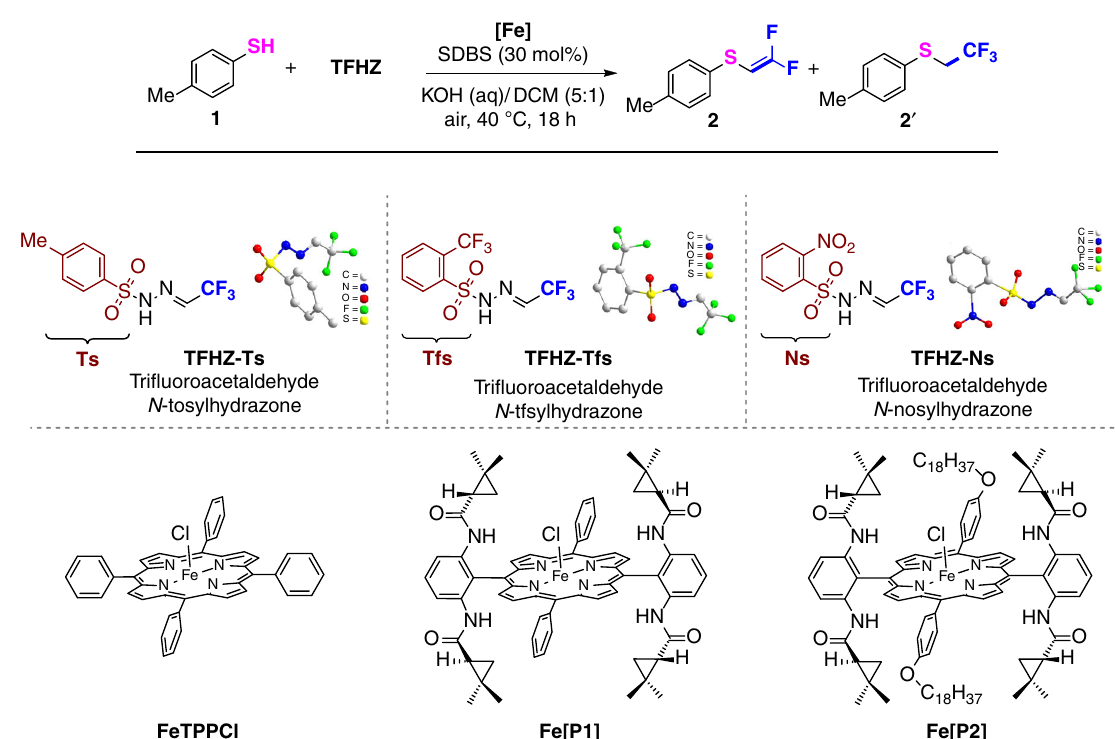
Fig. 2 Optimization of the iron-catalyzed gem -di fl uoroalkenylation of p -methylthiophenol with tri fl uoromethyl sulfonylhydrazones. Reaction conditions: thiophenol (0.3 mmol), sulfonylhydrazone (0.6 mmol), Fe porphyrin catalyst, SDBS (sodium dodecylbenzenesulfonate) (0.09 mmol), DCM (1.0 mL), and KOH solution (5.0 mL, 20% wt %), 40 °C, 18 h, under air. a Yields determined by 1 H NMR spectroscopic analysis with CH 2 Br 2 as an internal standard. b Reaction carried out under Ar atmosphere. c Yield in parentheses is the isolated yield